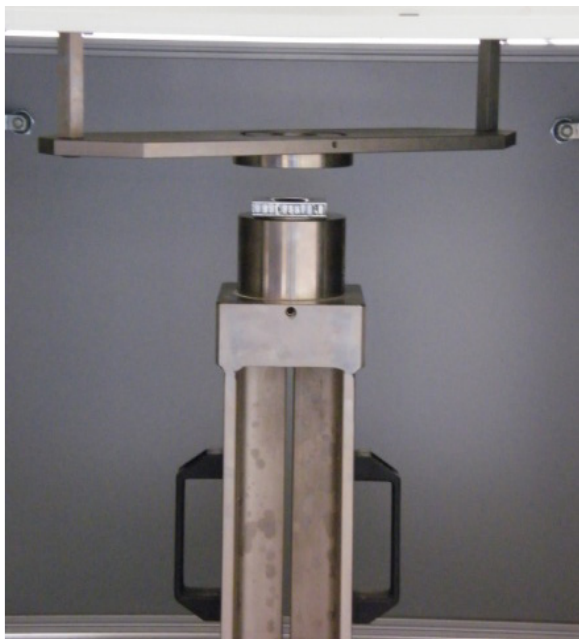
Figure 7. Clamping